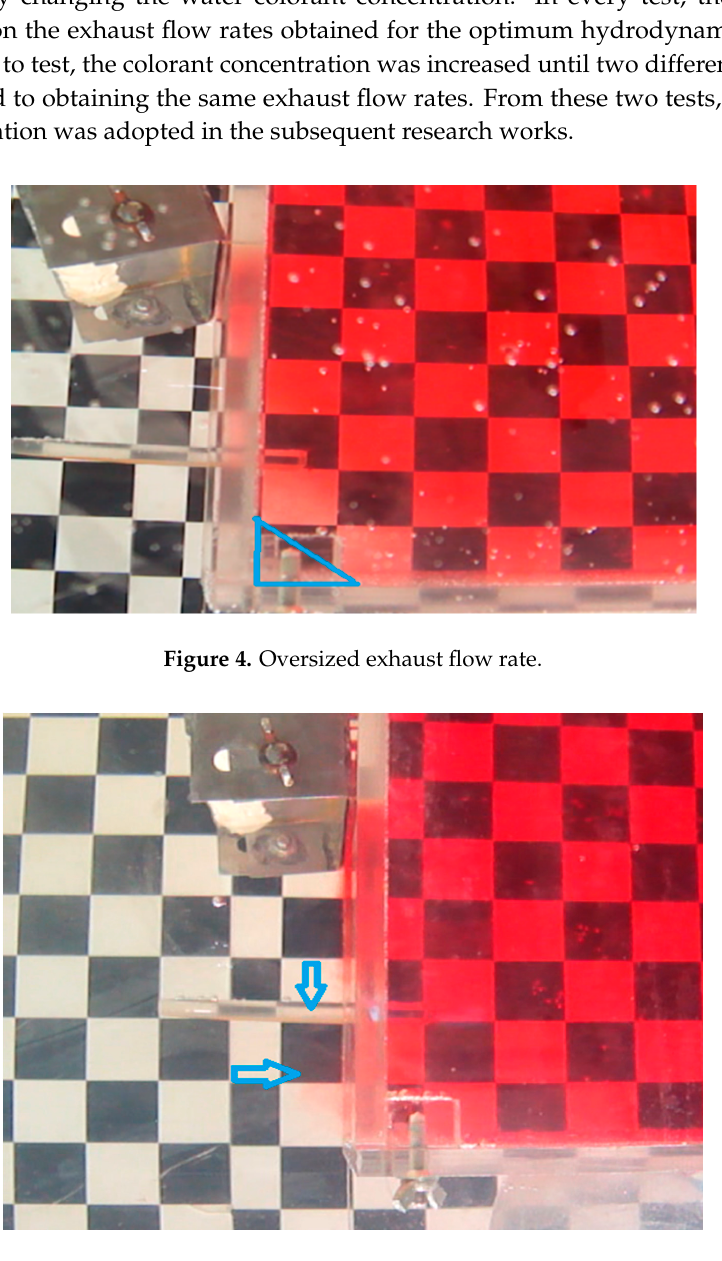
Table 1. Geometric characteristics of the jet.